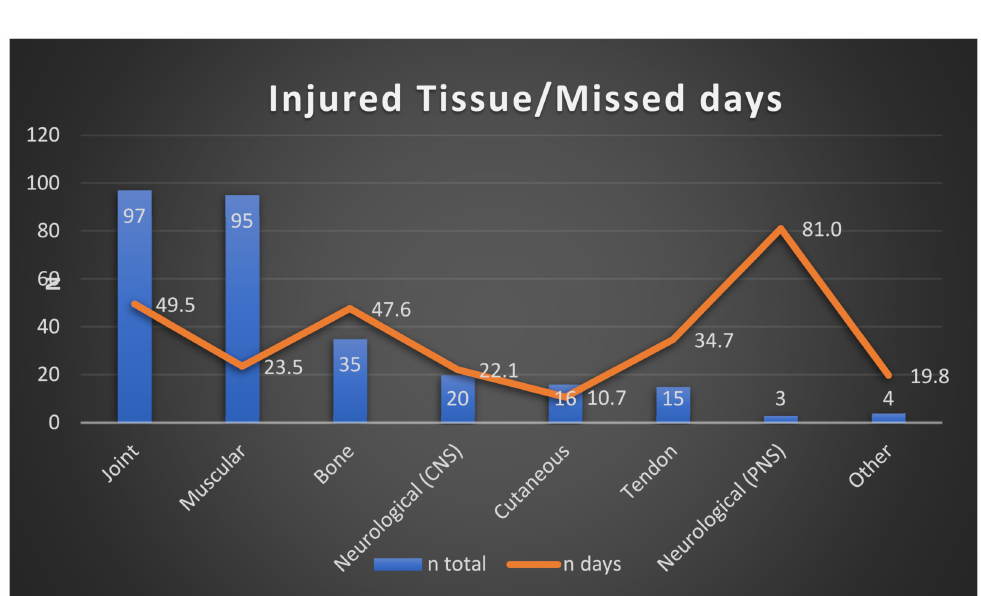
Figure 2. Injured tissue/missed